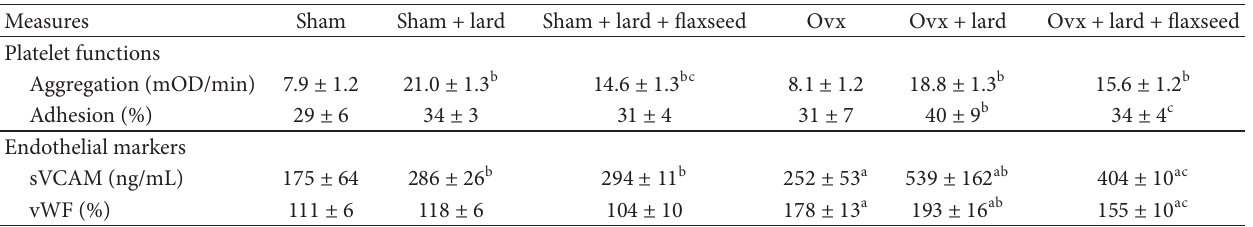
Table 2: Mean ± SD values for platelet functions and endothelial markers in studied